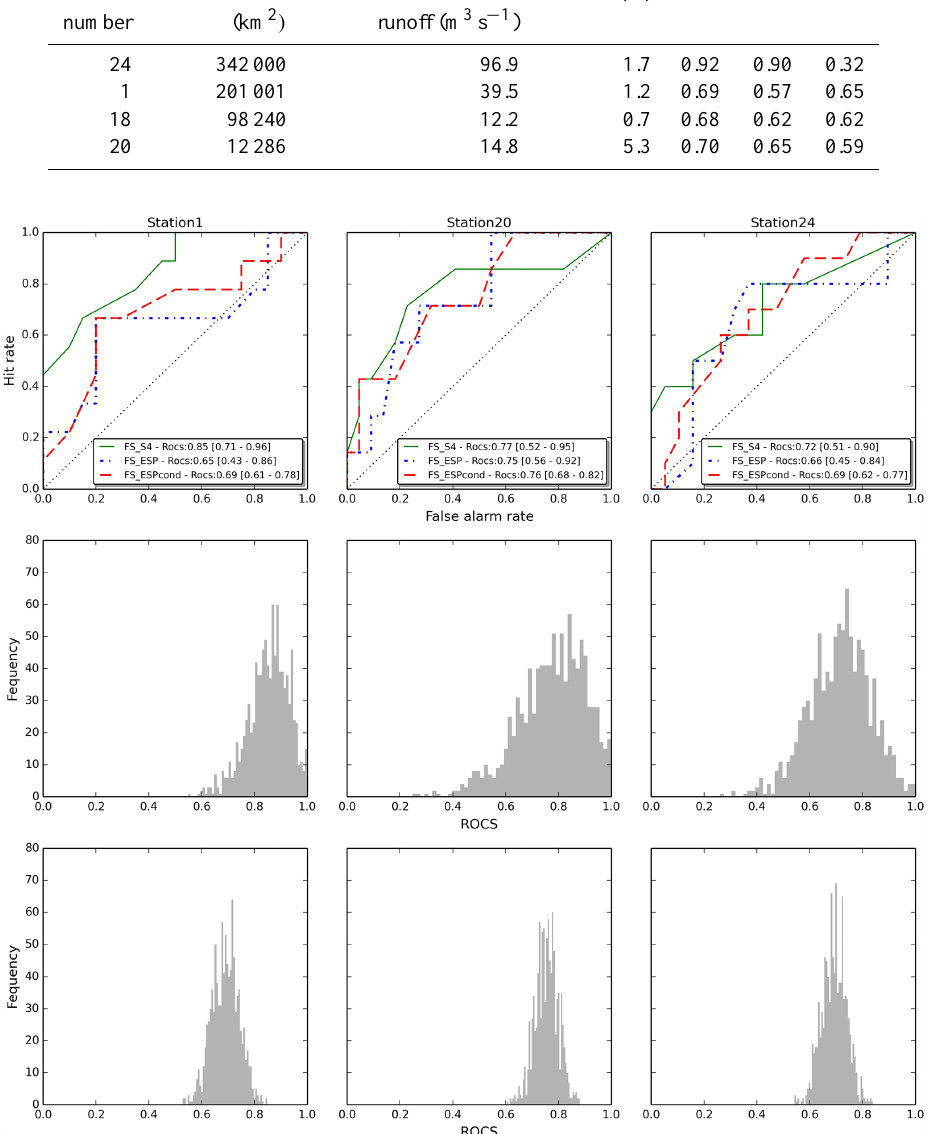
Figure 5. Upper plots: relative operating characteristic (ROC) diagram representing false alarm rate versus hit rate for the 6-month SRI (DJFMAM) ≤− 0.5 given by FS_S4, FS_ESP and FS_ESPcond for three stations (1, 20, and 24). The ROCS for each forecasting system together with the 90% confidence interval (5–95th percentiles) resulting from the bootstrap are indicated in the legend. Middle and bottom plots: histogram of the bootstrapped ROCS for FS_S4 (middle) and FS_ESPcond (lower), respectively, for the same three